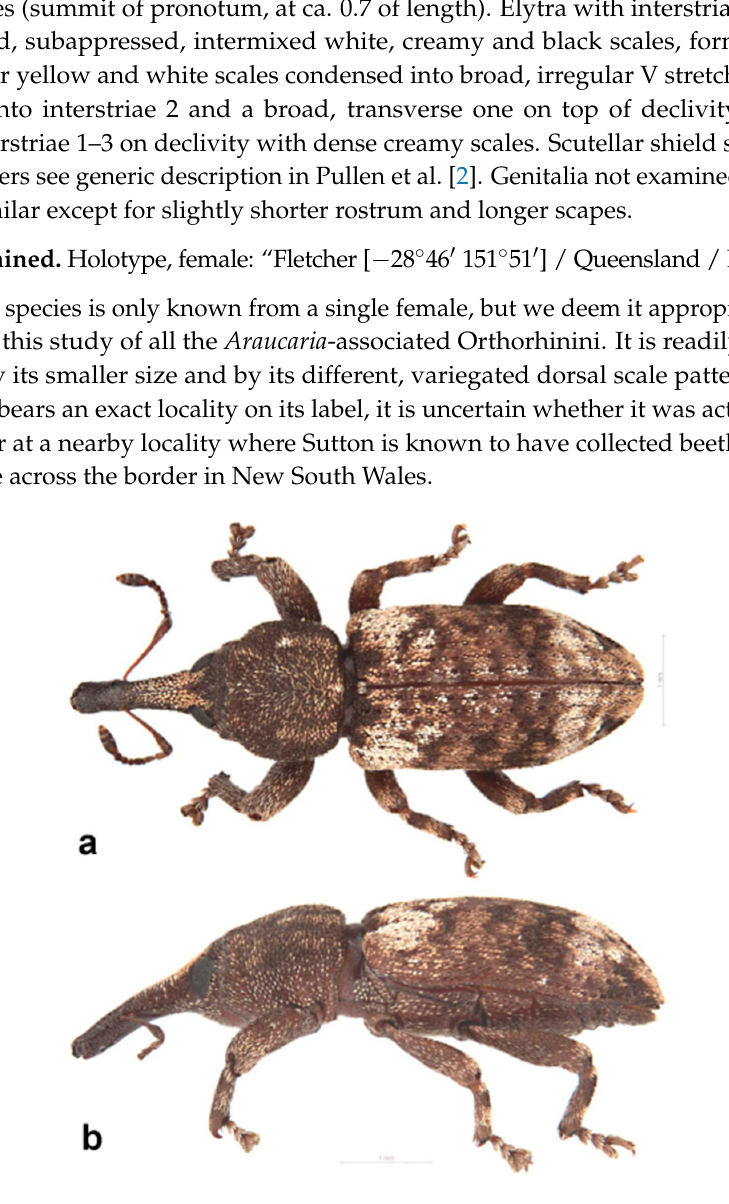
Figure 17. Notopissodes variegatus : ( a ) habitus of female, dorsal aspect; ( b ) habitus of female, lateral aspect.